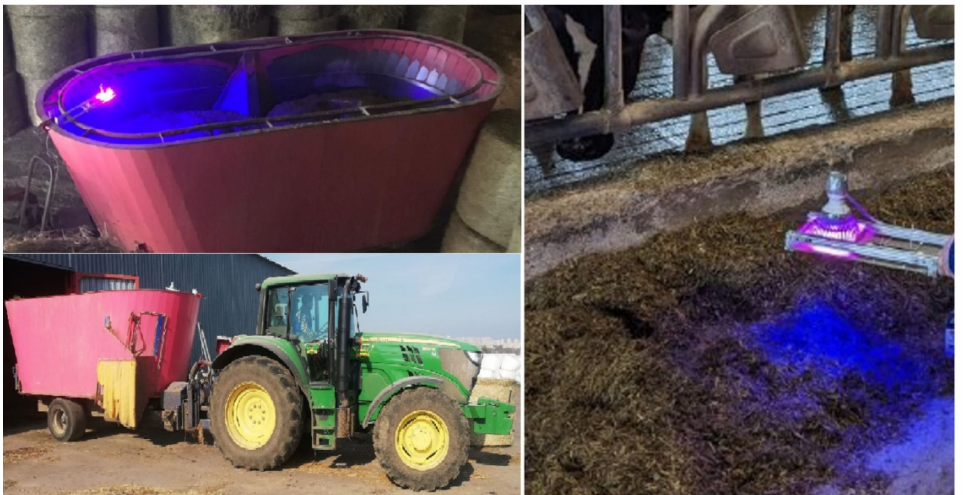
Figure 5. Process of getting images with fluorescence excitation of feed mix components on a